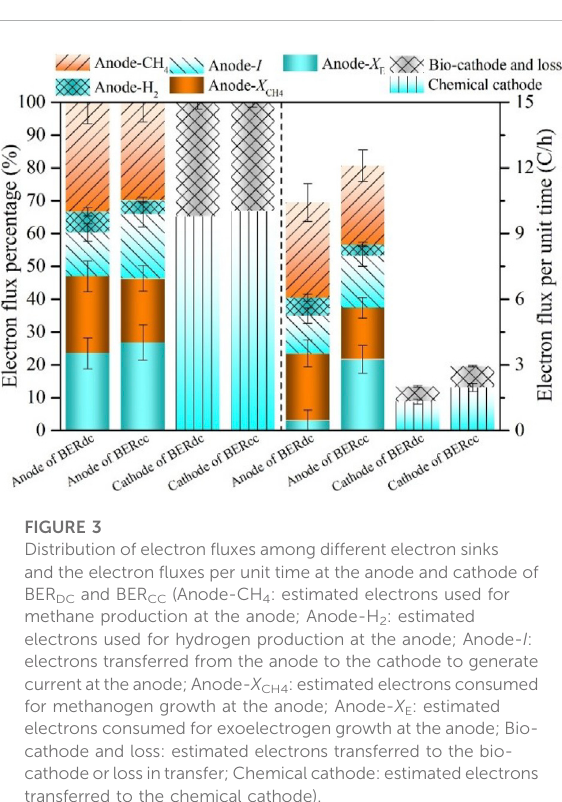
Figure 3, the proportions of electrons for methanogen growth, hydrogen production, methane production, and current generation (transferred along the anode) were 23.5% ± 2.7%, 6.4% ± 0.8%, 33.3% ± 3.5%, and 13.3% ± 1.7%, respectively. A